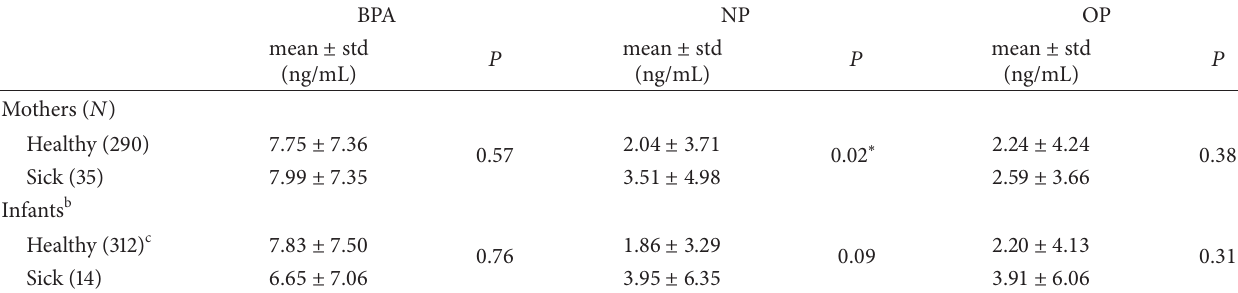
Table 4: Association between health status and total phenol levels a